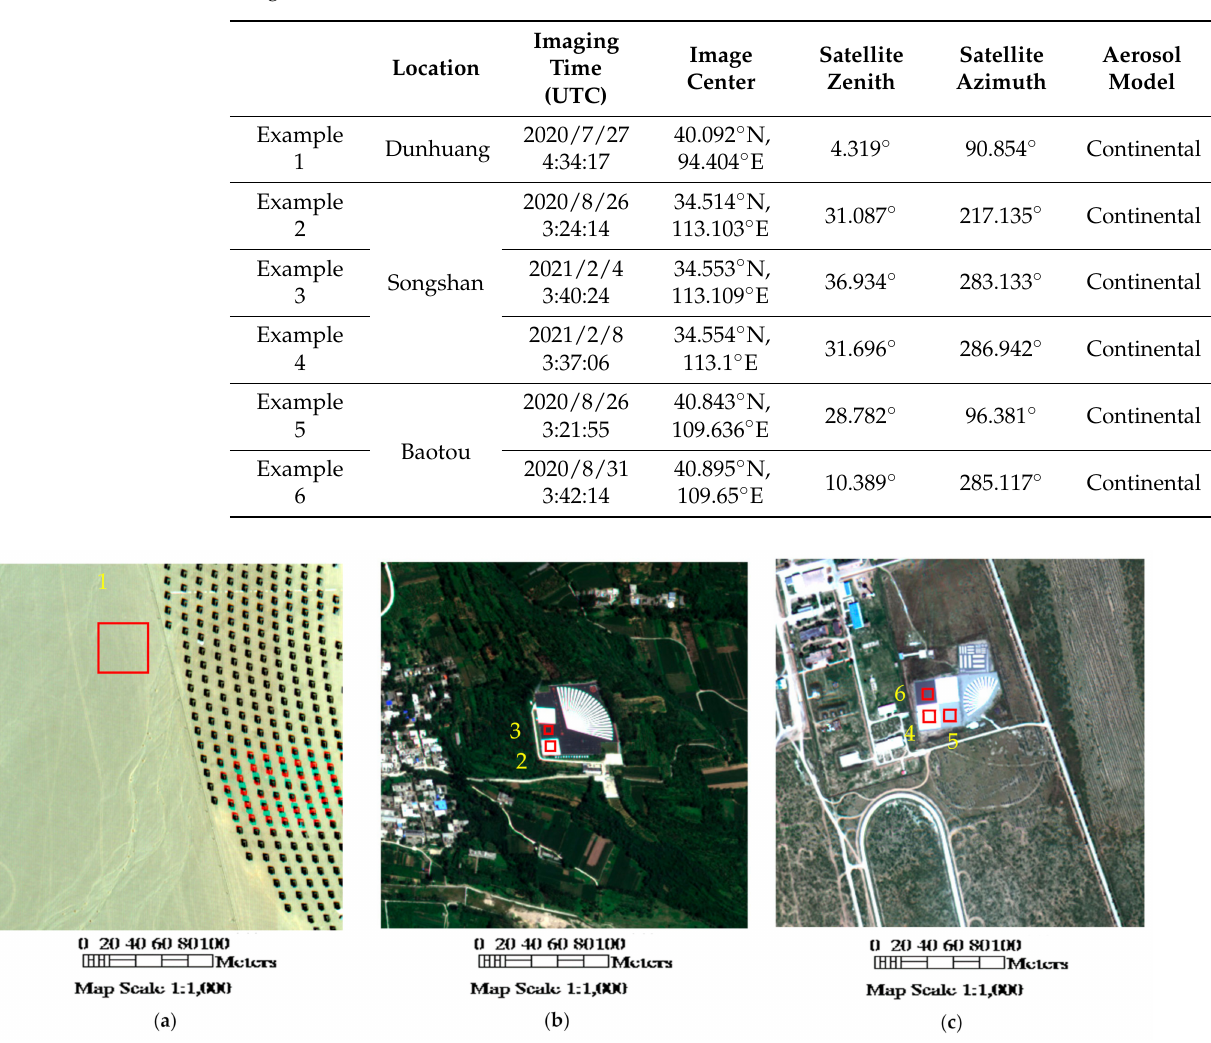
Table 4. Atmospheric parameters and observed geometric conditions of the images of Dunhuang, Songshan, and Baotou.